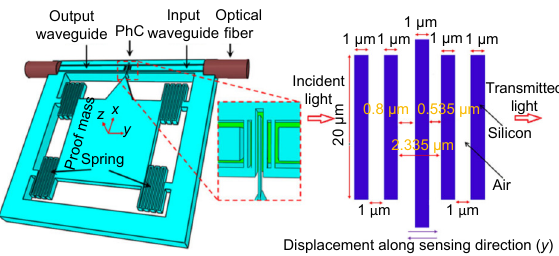
Fig. 24 | 3D model of a photonic crystal based accelerometer. Figure reproduced with permission from ref. 142 ,